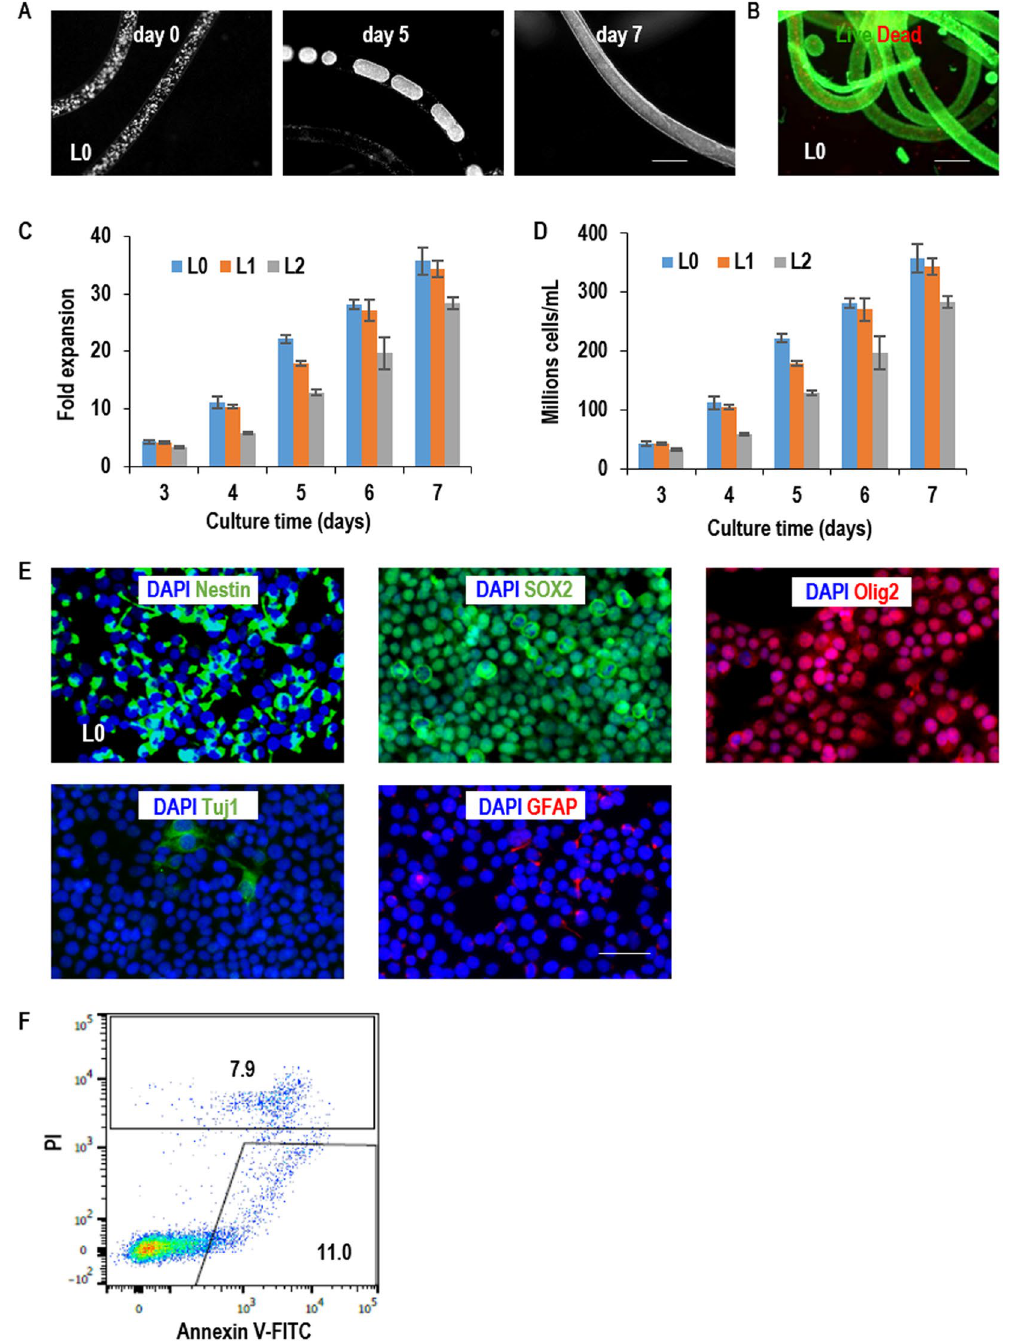
Figure 2. Culturing glioblastoma TICs in AlgTubes at passage 1. ( A ) Microscopy images of glioblastoma TICs (L0) in AlgTubes on day 0, 5 and 7. (B) Live/dead staining of day 7 cells in AlgTubes. ( C , D ) The expansion fold and volumetric yield of TICs from day 3 to day 7. When seeded at 1 × 10 7 cells/mL, L0, L1 and L2 expanded 36-, 34- and 28-fold, yielding 3.6 × 10 8 , 3.4 × 10 8 and 2.8 × 10 8 cells/mL by day 7, respectively. ( E ) Immunostaining of the cultured TICs. Cells were released from AlgTubes on day 7 and plated on a Laminin-coated plate overnight before fixing and staining. Majority of L0 cells were Nestin + , SOX2 + and Olig2 + . Few L0 cells were Tuj1 + and GFAP + . ( F ) Cell death was evaluated by Annexin V and PI staining after cultured in AlgTubes for 7 days. Error bars represent the standard deviation (n = 3). Scale bar: ( A , B ) 400 µ m, ( E ) 50 µ